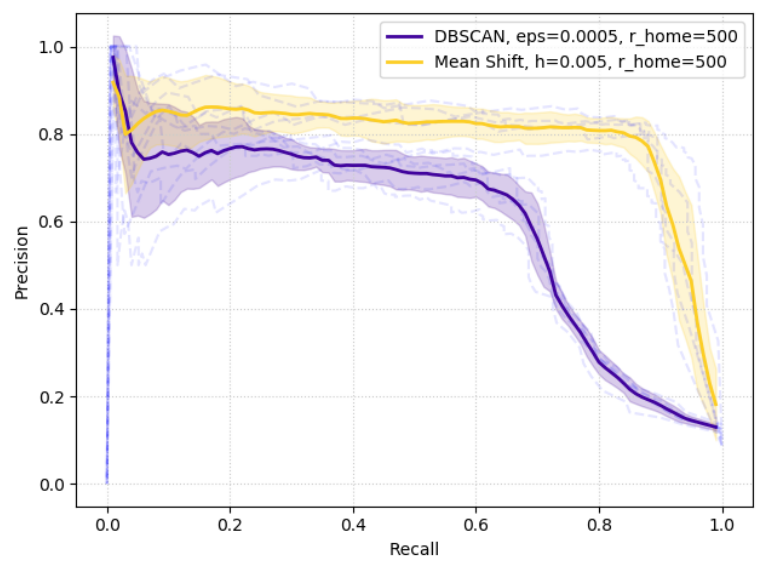
Figure 4. PR curves for best-performing setup from Mean Shift and